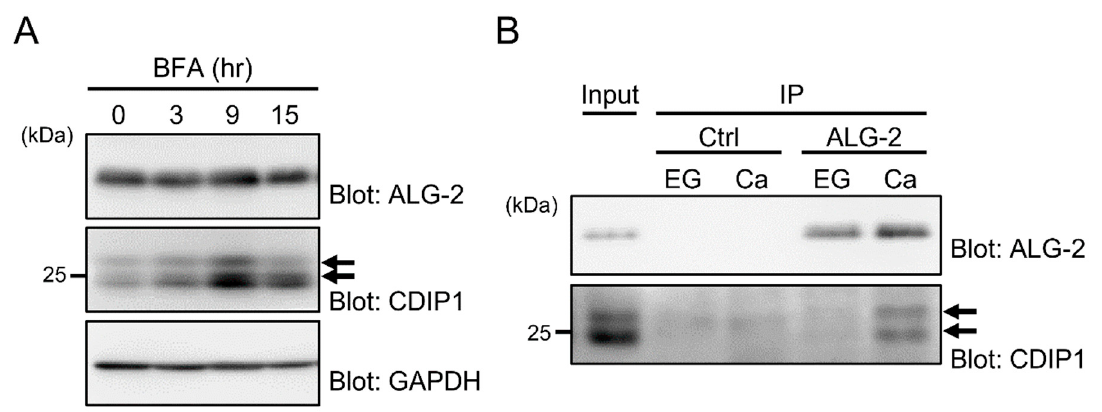
Figure 2. Interaction between ALG-2 and CDIP1 in cells treated with BFA. ( A ) BFA-induced expression of CDIP1. HEK293 cells were treated with 0.2 μ g/mL BFA for the indicated time, and the cell lysates were subjected to SDS-PAGE followed by immunoblotting with antibodies against ALG-2, CDIP1 and GAPDH. Doublet bands were detected by the antibody against CDIP1. ( B ) Co-IP assay of BFA-treated HEK293 cells. Cells were treated with BFA for 9 h, and the cleared cell lysate was immunoprecipitated with a polyclonal antibody against ALG-2 (ALG-2) or control IgG (Ctrl) in the presence of 5 mM EGTA (EG) or 10 μ M CaCl 2 (Ca). Cleared cell lysate proteins (Input) and immunoprecipitated proteins (IP) were subjected to SDS-PAGE followed by immunoblotting with antibodies against ALG-2 and CDIP1. The relative amounts of cleared cell lysate proteins (Input) used for analysis of IP products (IP) were 10% (upper panel) and 0.5% (lower panel). Arrows, non-ubiquitinated CDIP1 proteins.